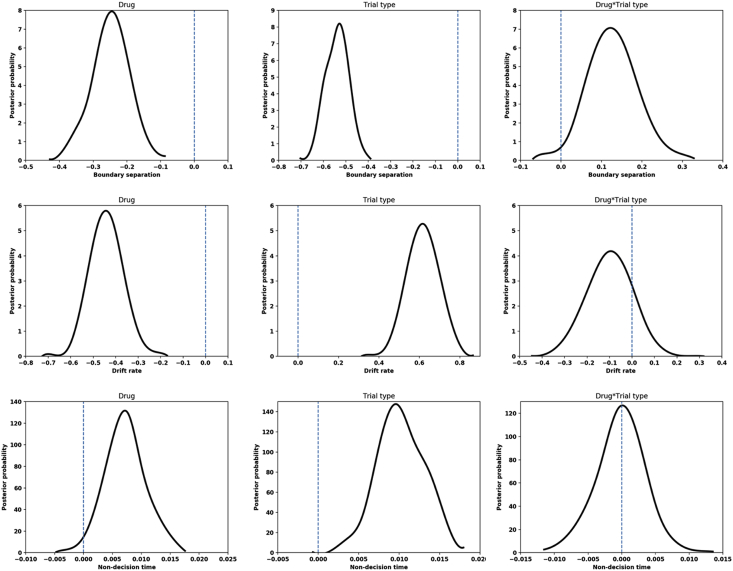
Drift-diffusion model parameters when participants were on ropinirole or placebo, during critical and non-critical Go trials.Posterior probability distributions are plotted for drug (ropinirole), trial type (non-critical) and an interaction between the two. The blue, vertical line represents the no-effect value. Statistical significance is confirmed if >95% of the distribution lies outside of this line. . (For interpretation of the references to colour in this figure legend, the reader is referred to the Web version of this article.)